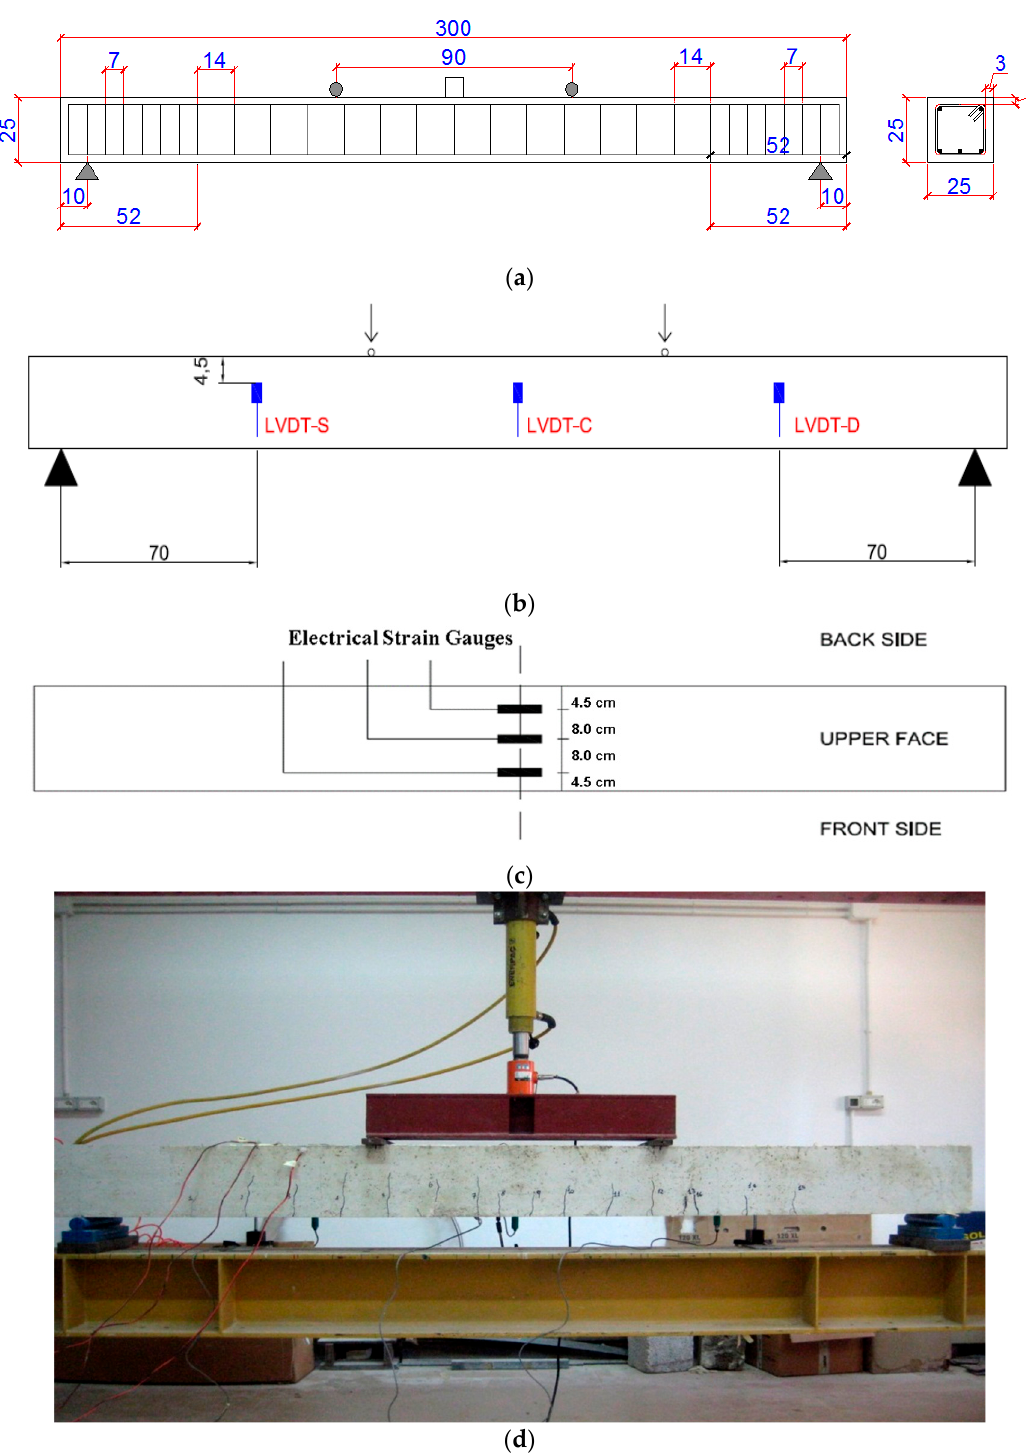
Figure 2. Reinforcement geometry ( a ); Back ( b ) and top ( c ) views of the instrumented beam—(measures in cm); final bending test ( d ).